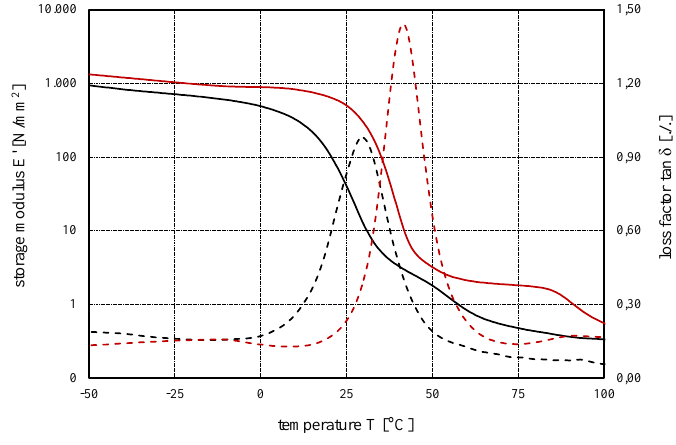
Fig. 1 Determination of thermomechanical properties by means of dynamic-mechanical analysis on conventional PVB film (Saflex ® -RB41, black curve) and structural PVB film (Saflex ® -DG41, red curve).